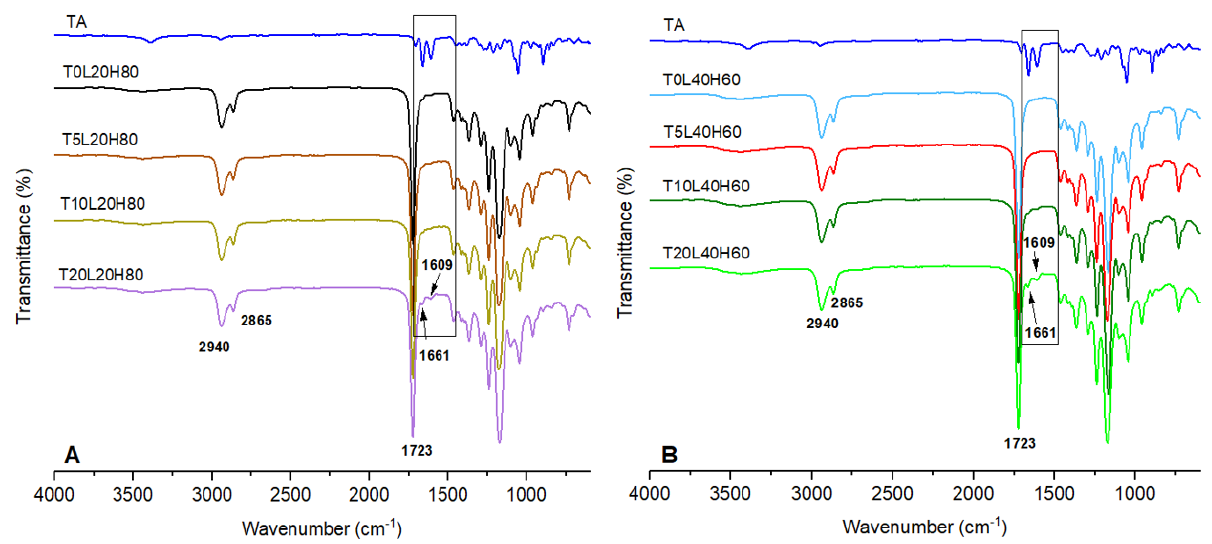
Figure 4. FTIR-spectra of ( A ) pure TA, blank PCL (T0L20H80), and TA-loaded in a matrix containing 20% L-PCL and 80% H-PCL, ( B ) pure TA, blank PCL (T0L40H60), and TA-loaded in a matrix containing 40% L-PCL and 60% H-PCL.